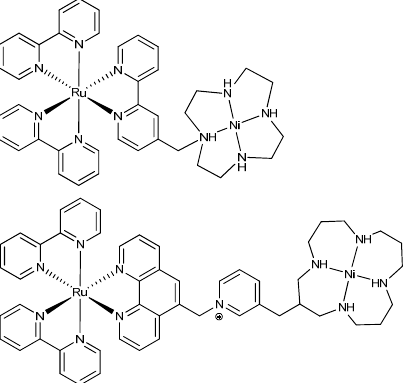
Figure 6. Bimetallic Ru-Ni catalysts for CO